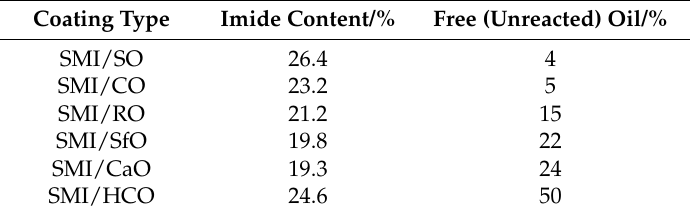
Table 2. Quantification of SMI/oil coatings on paper based on Raman